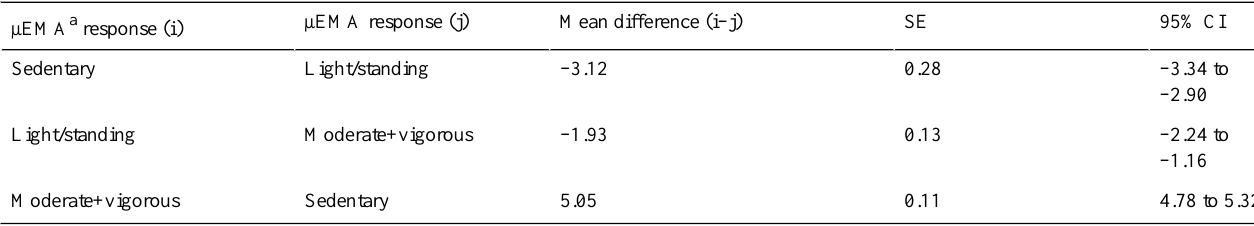
Table 3. Pairwise comparison of ln(Counts + 1) from activity monitor with μEMA